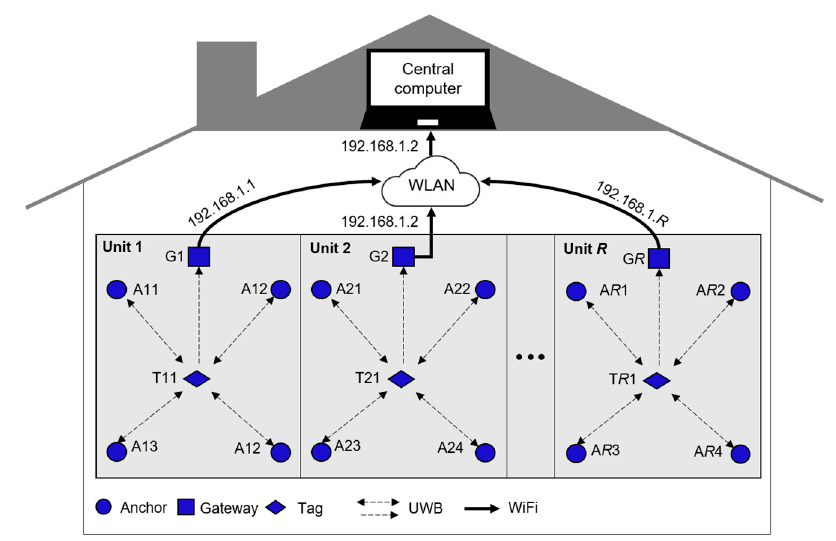
Figure 18. Networking topology to track pedestrians in whole building using UWB sensor network.